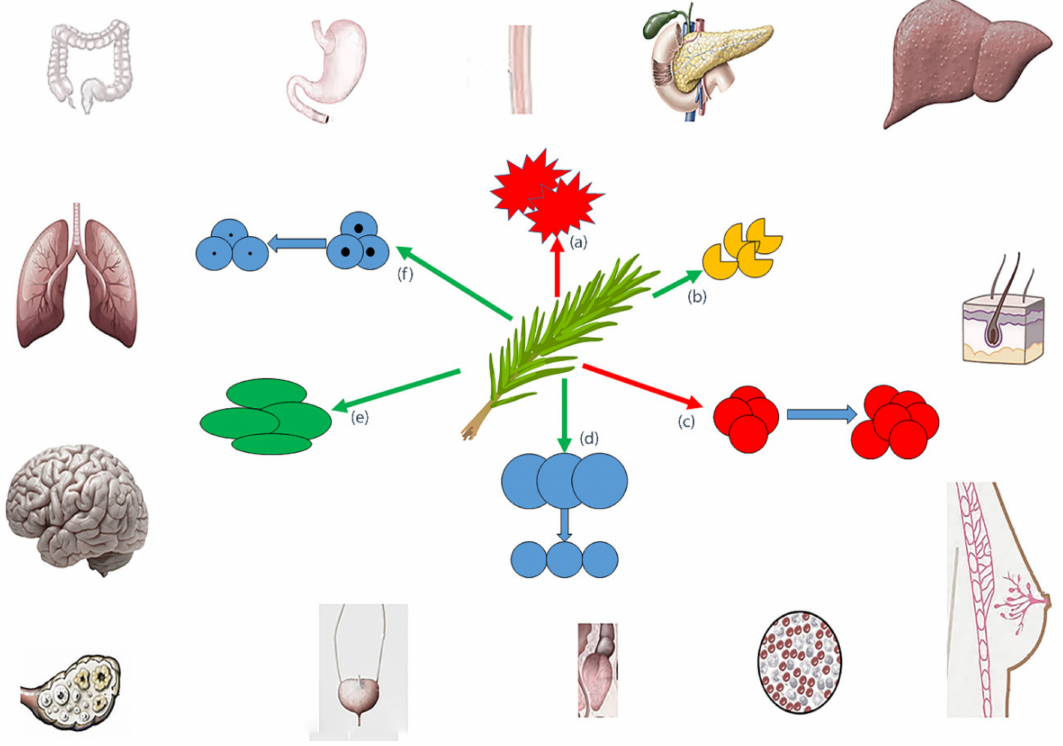
Figure 1. Rosemary e ff ects on various types of cancers (red arrows: inhibition / blockade; green arrows: promotion): ( a ) stopping the activation of carcinogens, ( b ) increasing antioxidant enzyme activities, ( c ) reducing tumour-stimulating inflammation, ( d ) decreasing cell growth, ( e ) stimulating programmed cell death, ( f ) promoting the reduction of tumour angiogenesis and